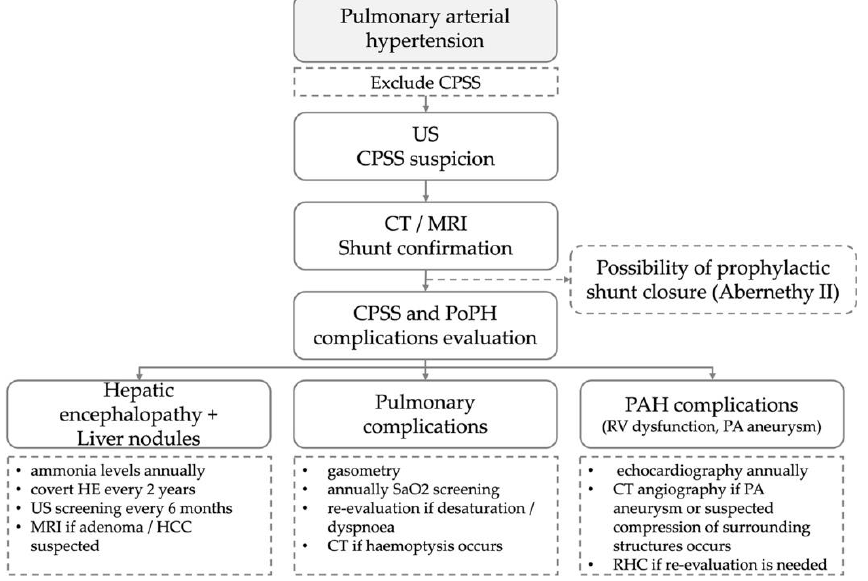
Figure 8. Algorithm for the diagnosis and follow-up of patients with congenital portosystemic shunts. CPSS—congenital portosystemic shunt; US—ultrasound; CT—computed tomography; MRI—magnetic resonance imaging; PoPH—portopulmonary hypertension; HE—hepatic encephalopathy; HCC—hepatocellular carcinoma; SaO2—oxygen saturation in arterial blood; PAH—pulmonary arterial hypertension; RV—right ventricle; PA—pulmonary artery; RHC—right heart catheterization.